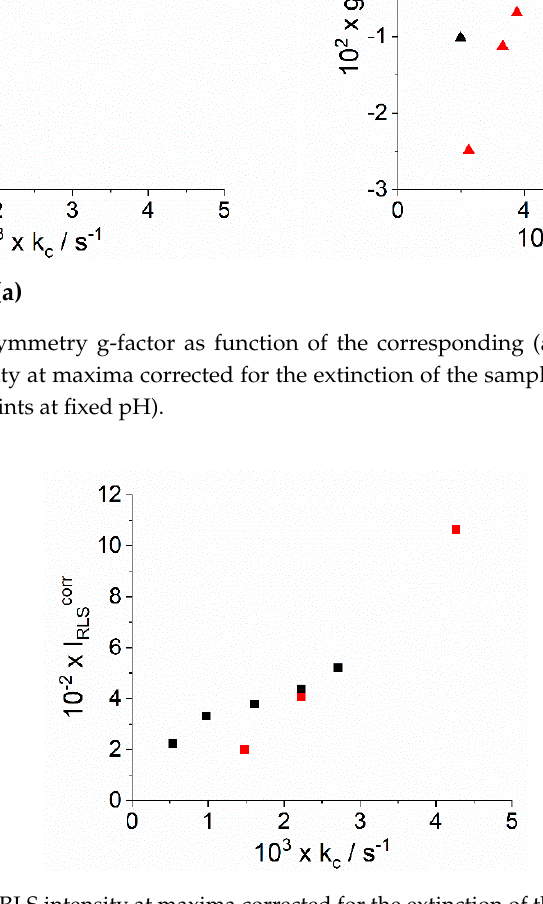
Figure 10. Plot of the RLS intensity at maxima corrected for the extinction of the samples as function of the corresponding rate constants k c (black points at fixed ionic strength, red points at fixed pH).